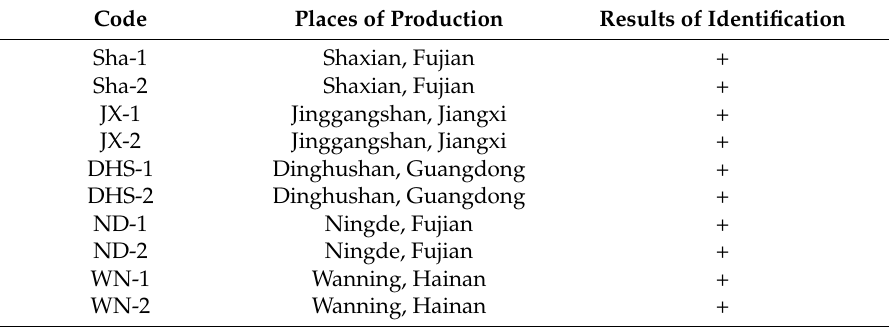
Table 2. Authenticity identification of the crude drug of Wuzhimaotao from different sources.